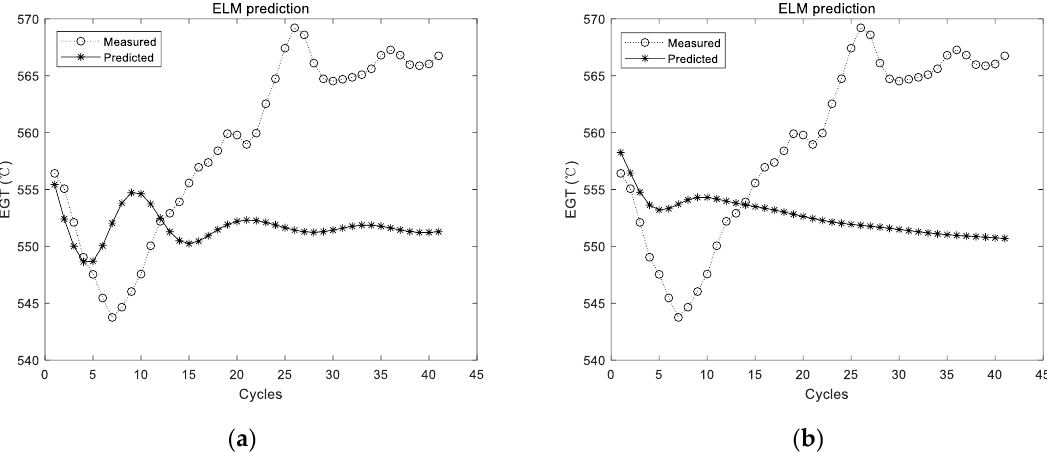
Figure 5. Experimental results of ELM prediction using the first group of data. ( a ) The first experimental results; ( b ) the second experimental results.